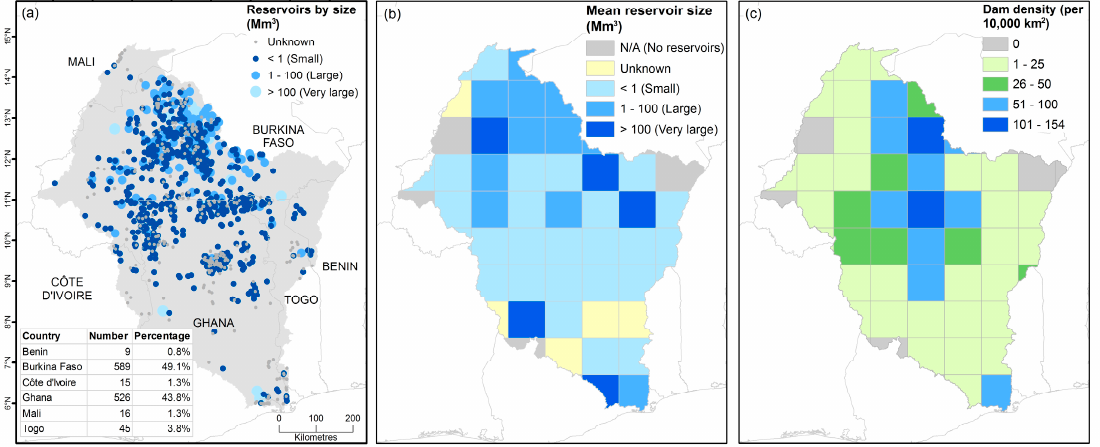
Figure 4. (a ) Reservoir locations and size, ( b ) mean reservoir size, and ( c ) reservoir density across the six Volta basin countries.